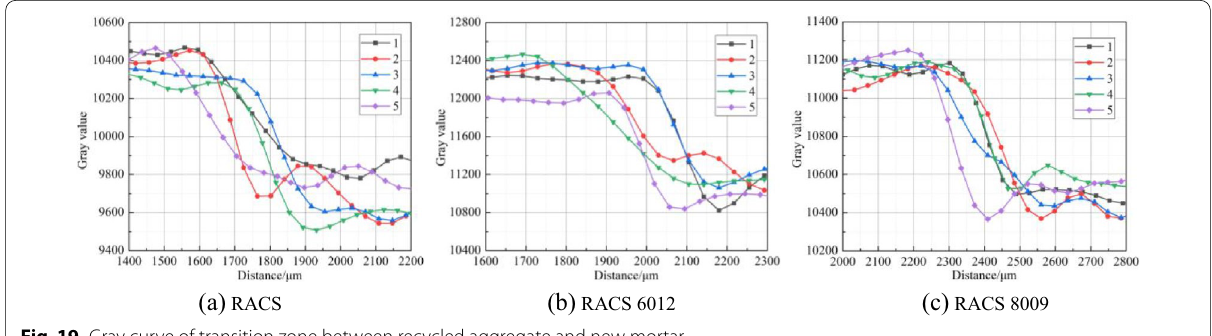
Fig. 19 Gray curve of transition zone between recycled aggregate and new